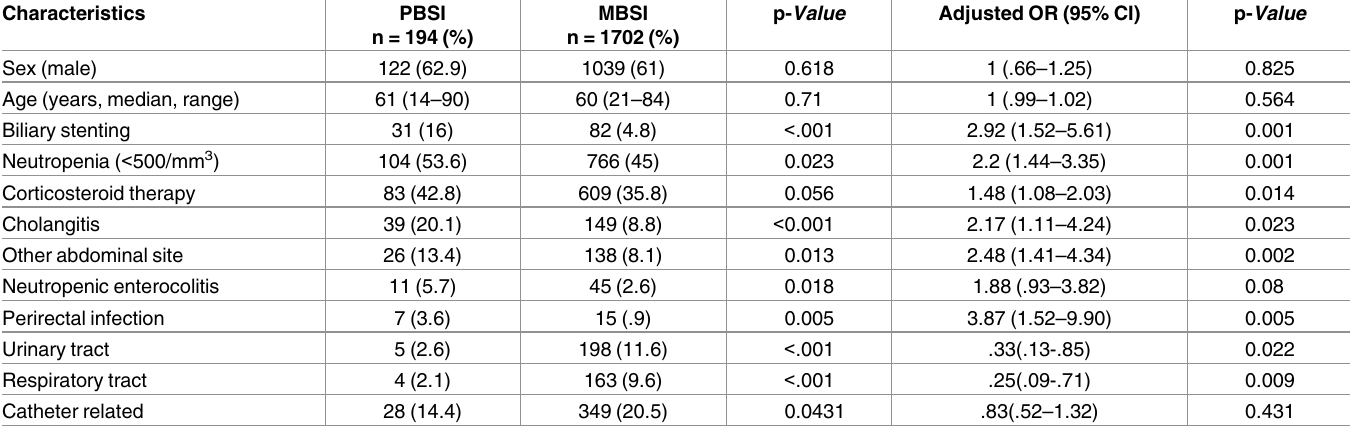
Table 2. Risk factors for polymicrobial bloodstream infection by univariate and multivariate analysis.